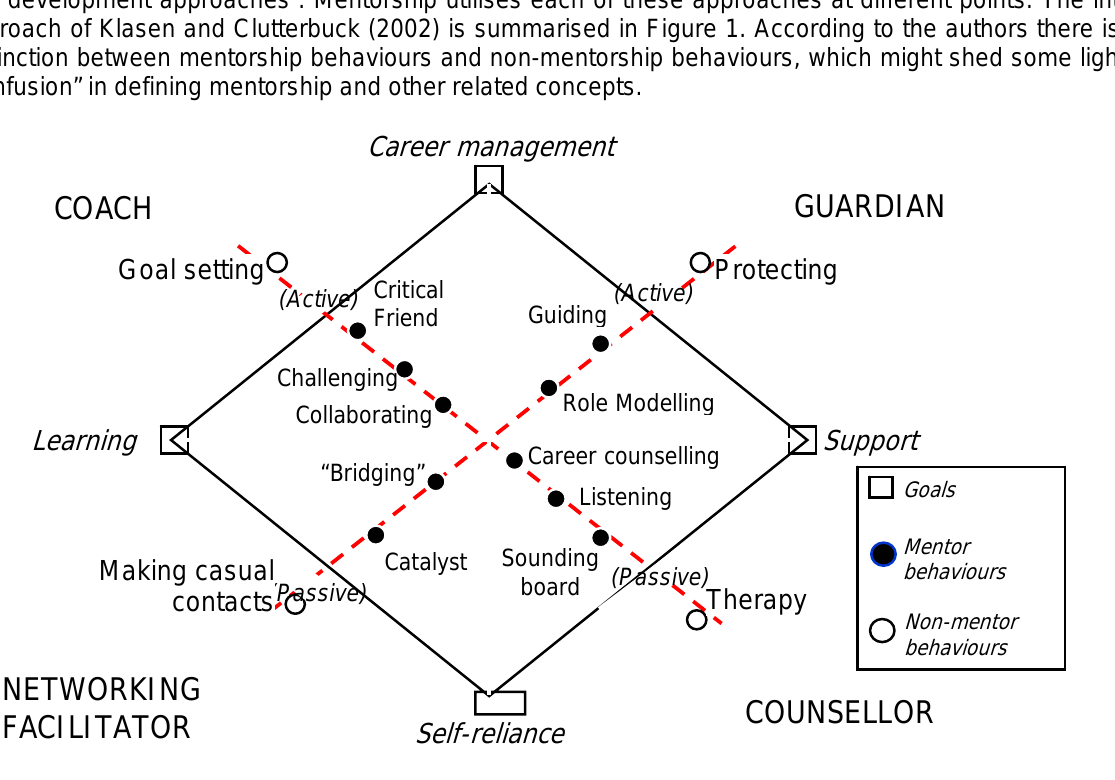
Figure 1 . Mentorship model – Klasen & Clutterbuck